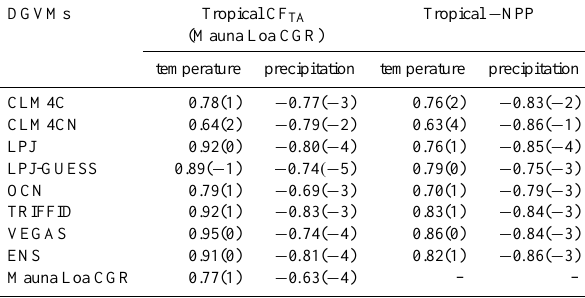
Table 4. The maximum correlations of the simulated tropical ter- restrial carbon cycle variability with temperature and precipitation. Lead-lag months between the carbon cycle variability and climatic variables are given in brackets. Positive values indicate that climatic variables lag